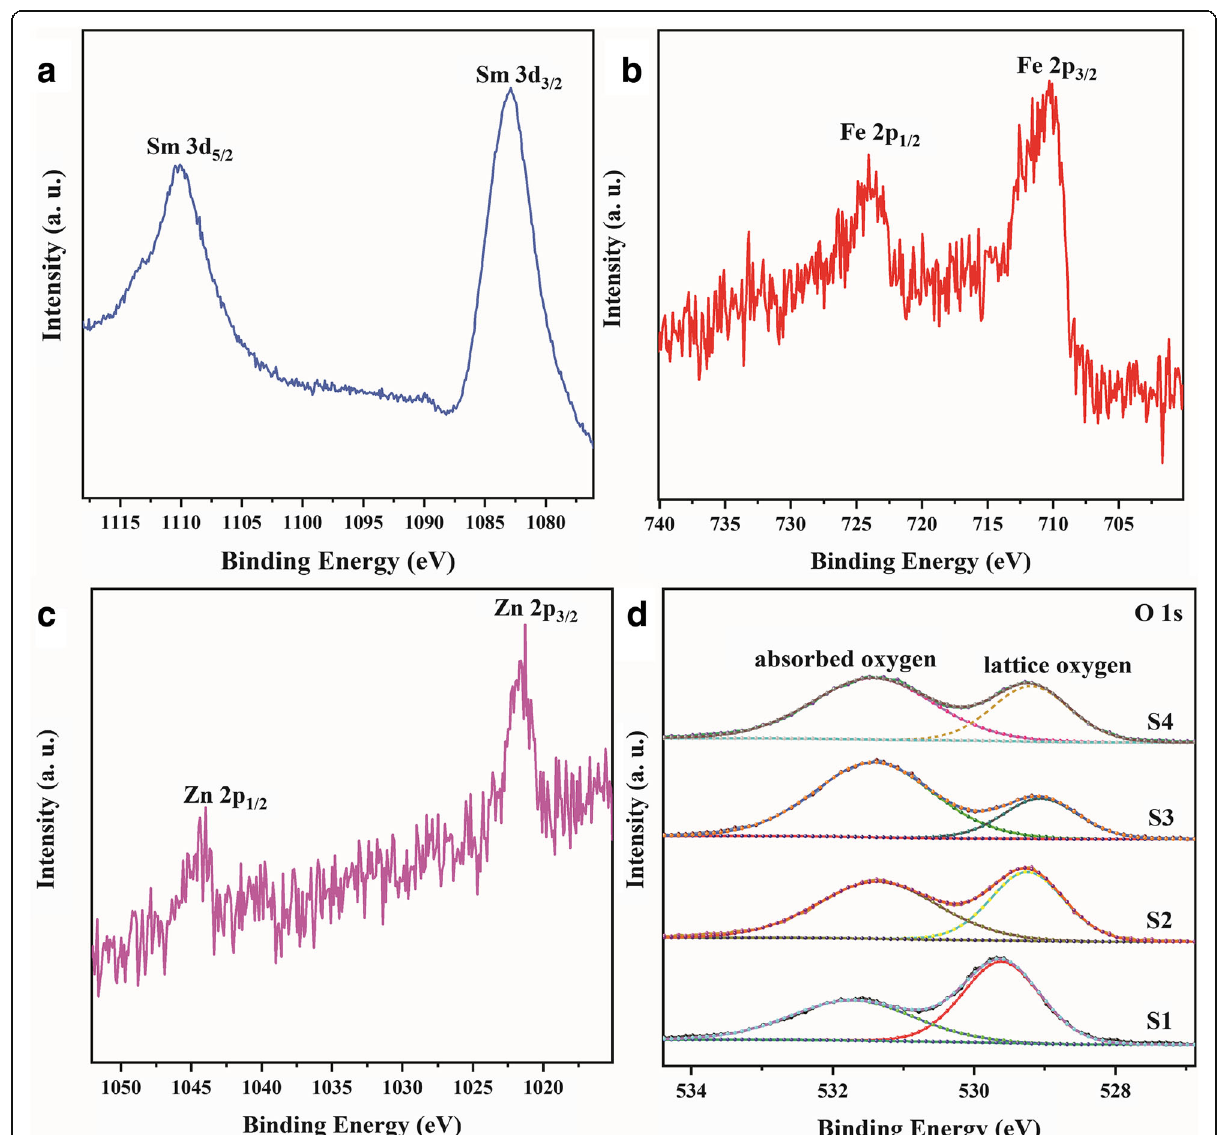
Fig. 6 High-resolution XPS spectra of Sm ( a ), Fe ( b ), Zn of S3 ( c ), and O 1 s of S1, S2, S3, and S4 ( d